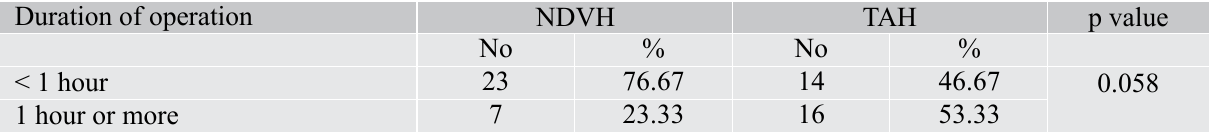
Table III: Comparison of amount of blood loss between NDVH and TAH groups (N=60) Amount of blood loss < 50 mL 50 mL or more Table IV: Comparison of duration of operation between NDVH and TAH groups (N=60) Duration of operation